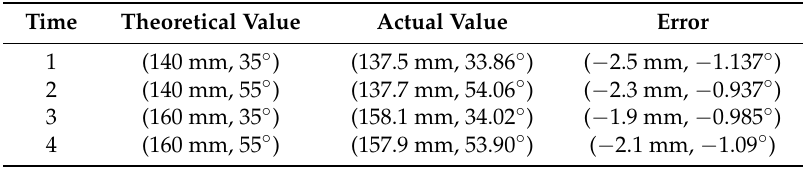
Table 2. Experiment results for surface